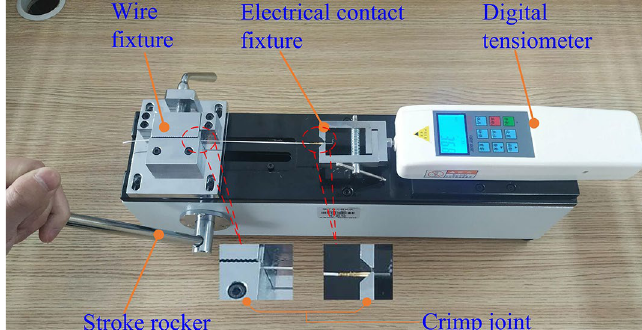
Figure 7. Pull-out force detection of crimp terminals.